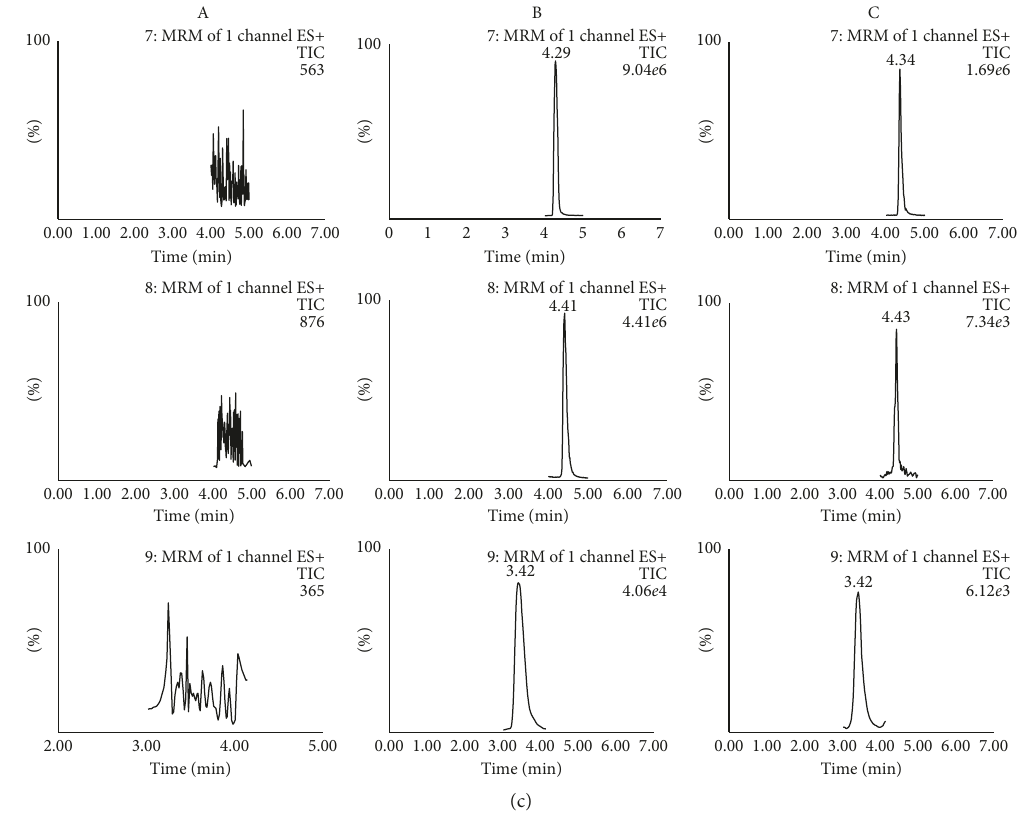
Figure 2: Representative MRM chromatograms of eight analytes and quercetin (IS). (a) Blank plasma. (b) Blank plasma spiked with the eight analytes and IS. (c) Plasma sample 1h after oral administration of DRE (4g/kg) (mean ± SD, n �